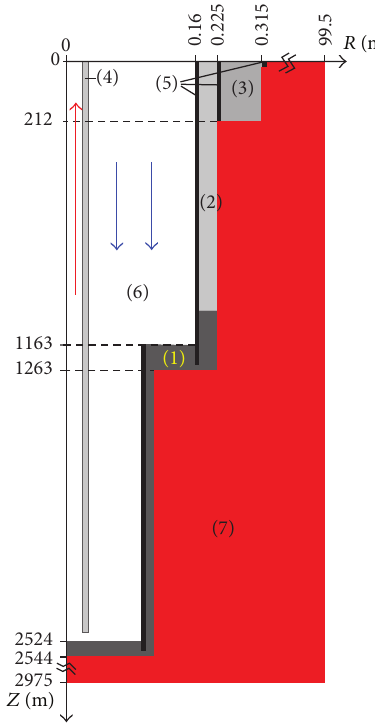
Figure 9: The used 2D cylinder grid (radius 99.5 m and